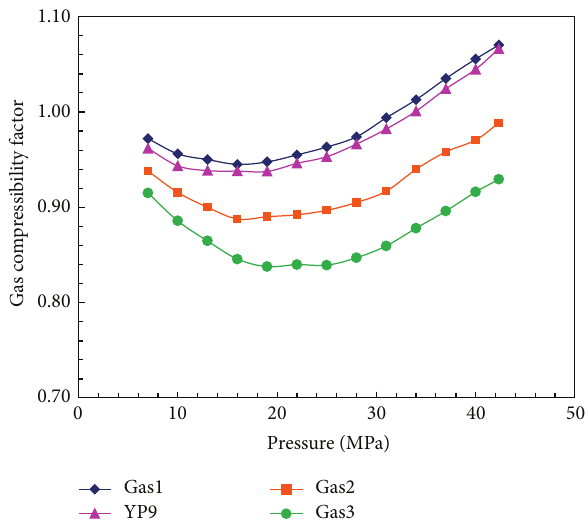
Figure 12: Variation of the 𝑍 -factor of different CO 2 content natural gas samples with pressure at 127.5 ∘ C.